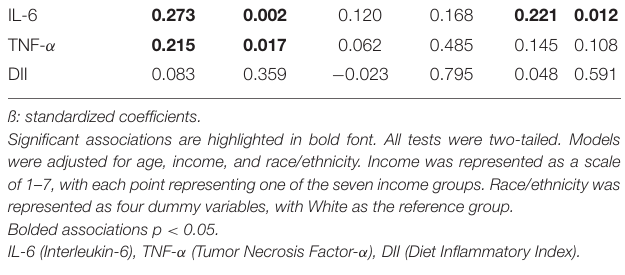
TABLE 3 | Summary of multiple regression analysis examining the adjusted relationship between inflammation measures and dimensions of depression and total BDI-II scores.